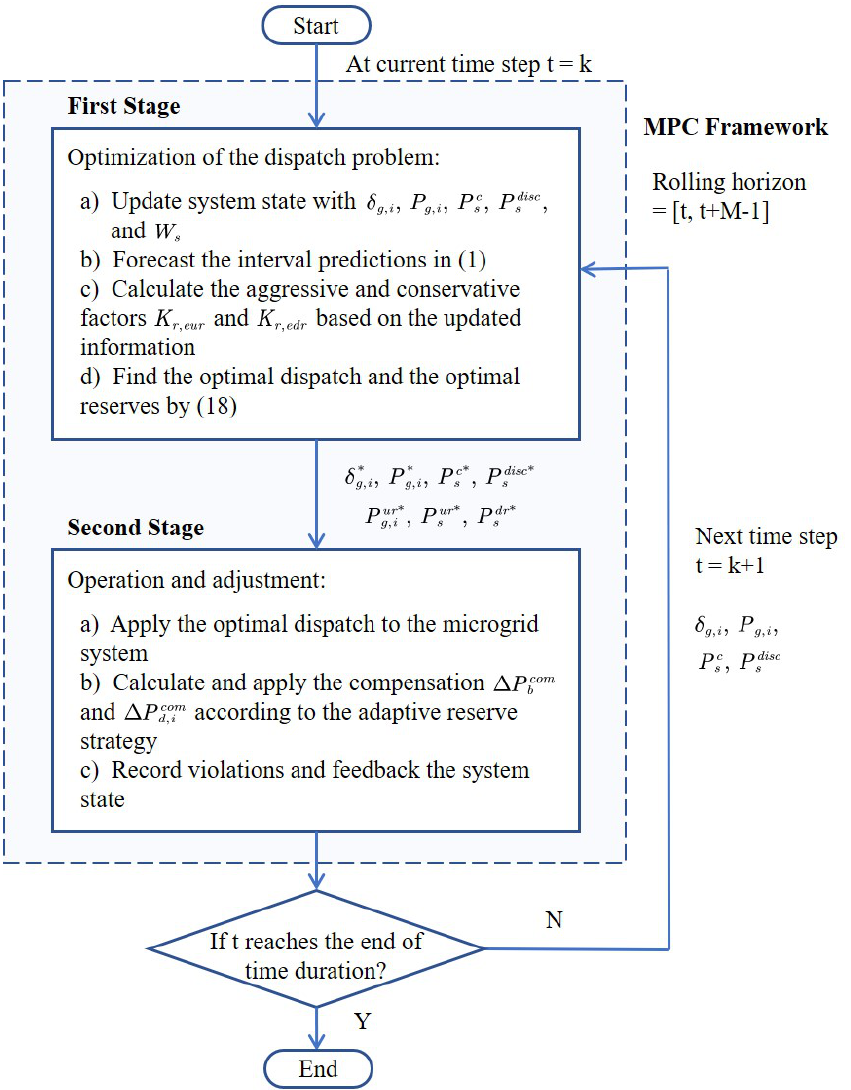
Figure 3. The schematic diagram of the two stage control model using the Model Predictive Control (MPC) framework and adaptive reserve